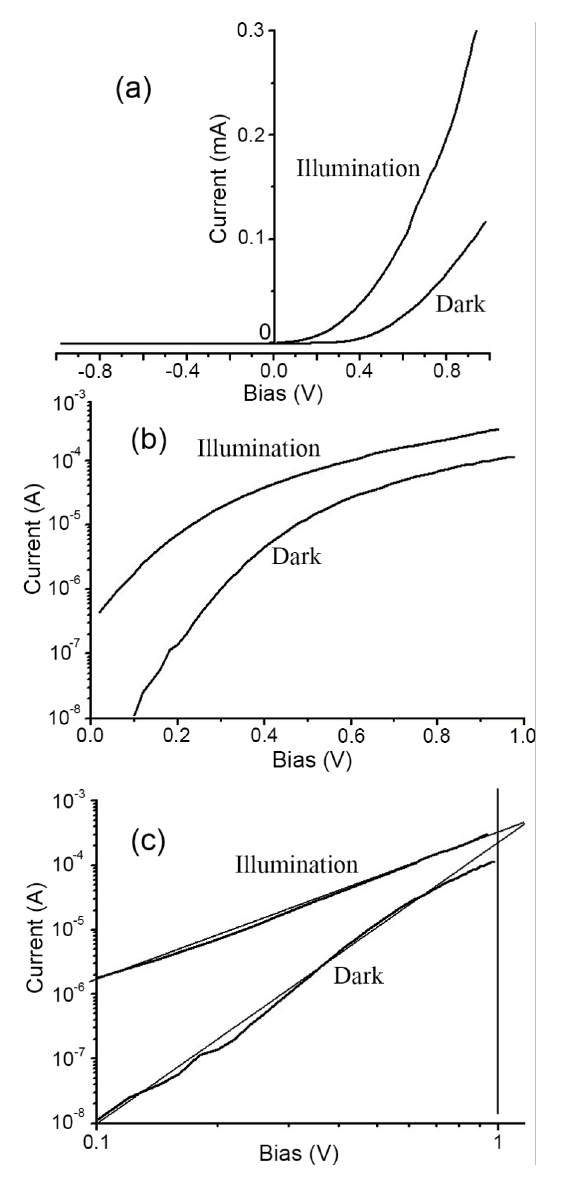
Figure 10: Current–voltage characteristics in dark and under UV illumi- nation for a p-Si/n-Zn 0.6 Mg 0.4 O heterostructure plotted on linear (a), semi-logarithmic (b) and double logarithmic coordinates